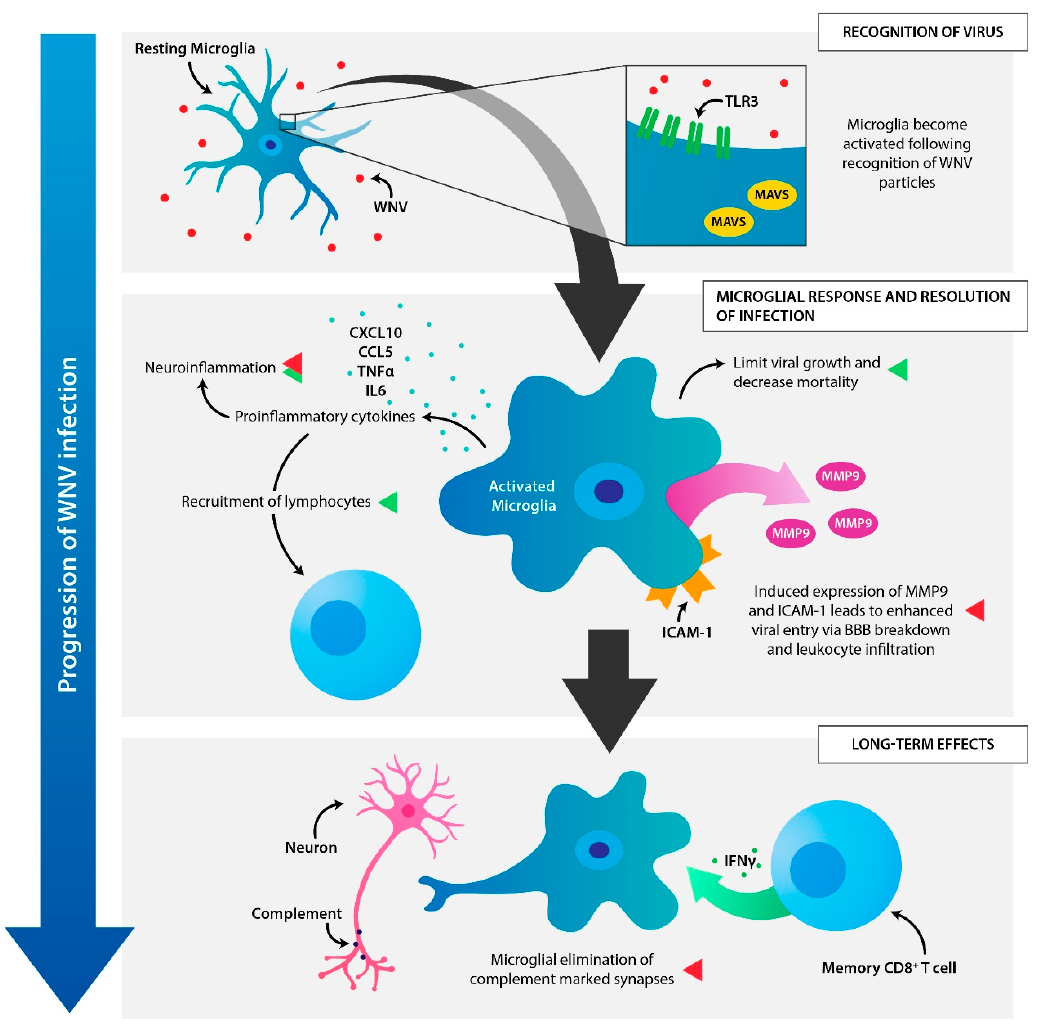
Figure 2. The many roles of microglia during a WNV infection. RECOGNITION OF VIRUS: Microglia recognize WNV viral particles in the CNS through multiple signaling pathways, including TLR3 / MAVS [1,2]. MICROGLIAL RESPONSES AND RESOLUTION OF INFECTION: Microglia become activated in response to WNV infection and initiate morphological and functional changes [3]. Activated microglia control viral growth and reduce mortality in mice infected with WNV [4], likely due to a combination of microglial phagocytosis of infected neurons and the release of inflammatory cytokines, which contribute to neuroinflammation and the recruitment of lymphocytes [3,5]. In some cases, released cytokines may contribute to WNV-induced pathogenesis. MMP9 and ICAM-1 expression by microglia may enhance viral entry into the CNS through breakdown of the BBB and extravasation of potentially infected leukocytes [6,7]. LONG TERM EFFECTS: Following infiltration of T cells into the CNS, microglia may contribute to synaptic damage triggered by IFN γ produced by memory CD8 + T cells and enhanced by the complement cascade [8,9]. This synaptic elimination leads to neurological damage during recovery from WNV encephalitis [9]. Green and Red indicator arrows designate protective (green) and non-protective (red) microglial